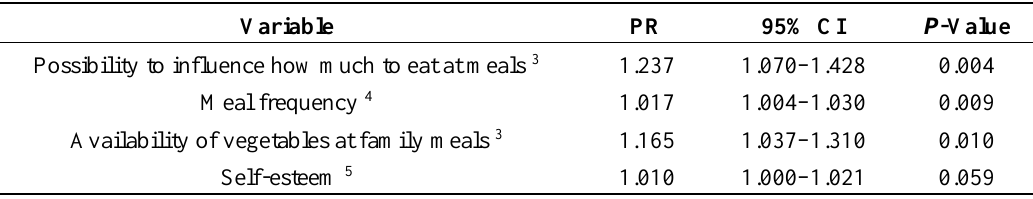
Table 4. Factors related to presumed eating competence 1 , multivariate Poisson regression model ( n = 540 out of 976 2